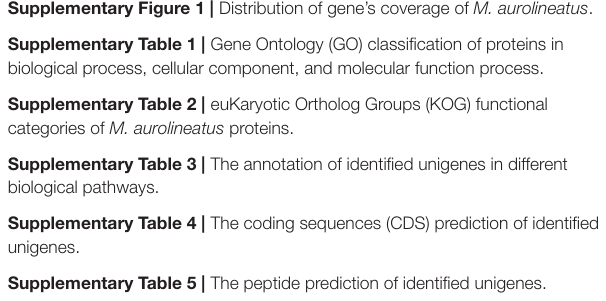
Supplementary Table 5 | The peptide prediction of identified